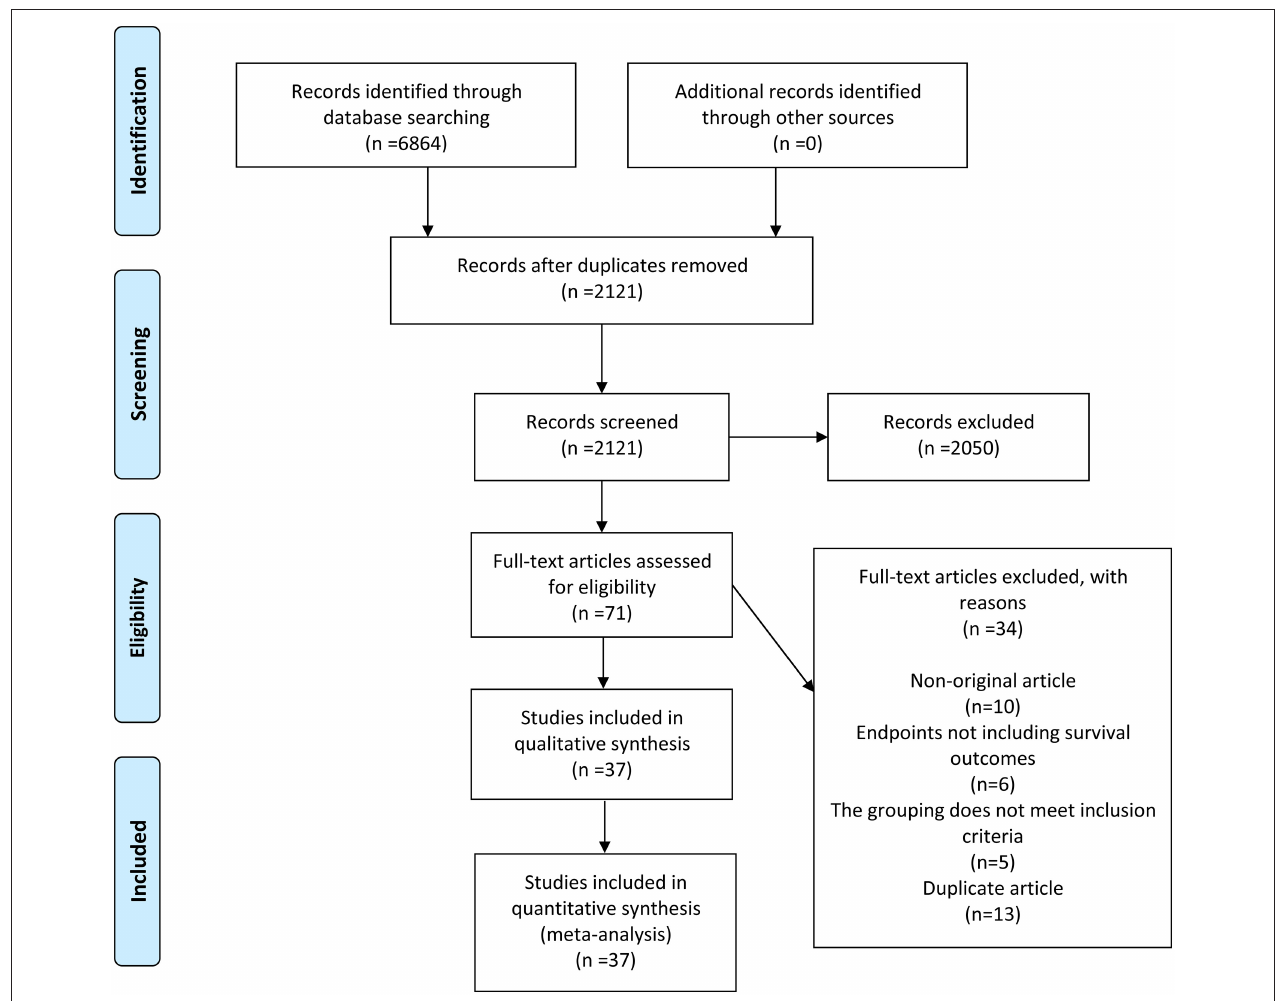
FIGURE 1 | A schematic flow for selecting the articles included in the